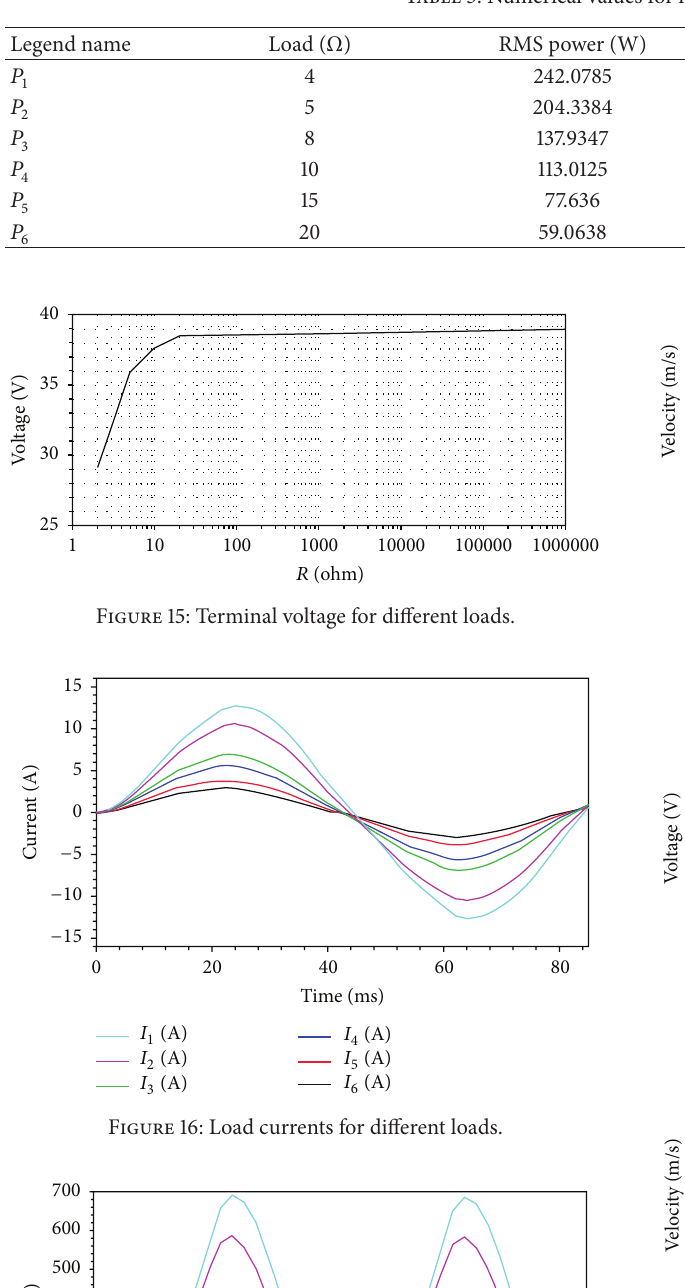
Table 3: Numerical values for legend of Figure 17.